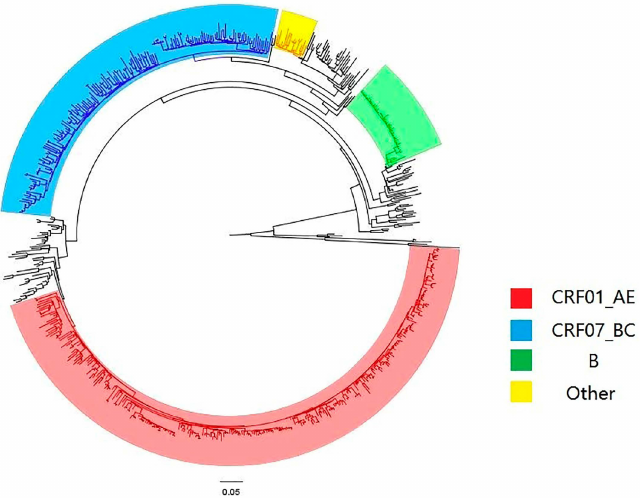
Figure 1. Phylogenetic tree diagram of the system.